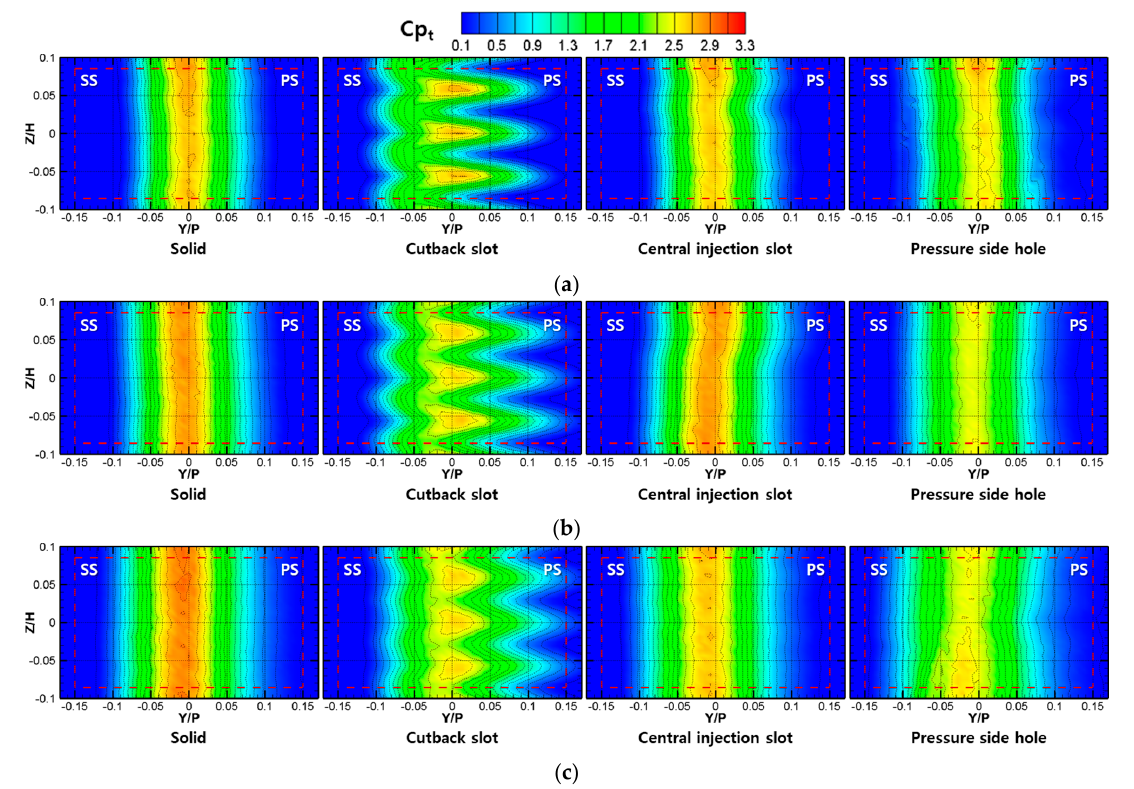
Figure 8. Distribution of the total pressure loss coefficient for different trailing edge diameters at M = 0.0: ( a ) d TE /T = 7.5%; ( b ) d TE /T = 10.0%; ( c ) d TE /T = 12.5%.